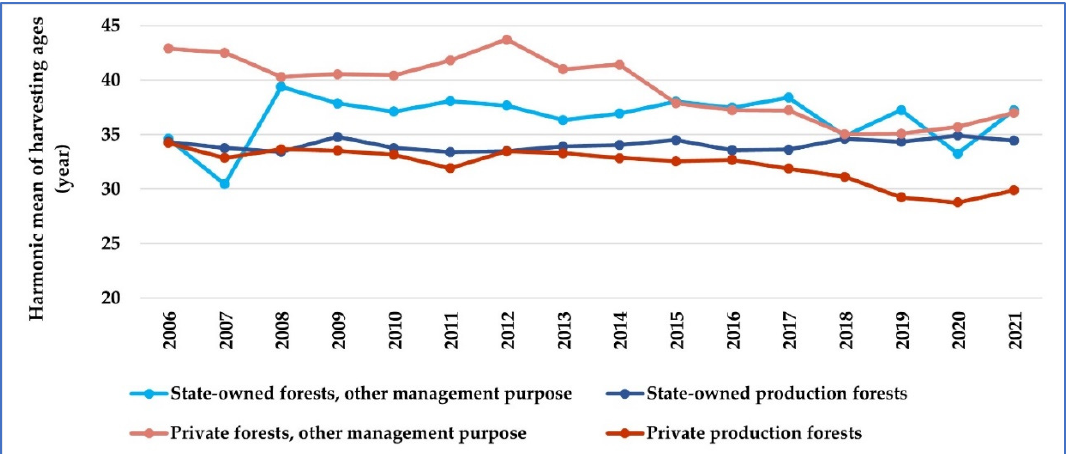
Figure 7. Harmonic mean of harvesting ages (weighted by the area under harvest) of black locust ( Robinia pseudoacacia ) stands in the period between 2006 and 2021 grouped by management purpose and ownership.